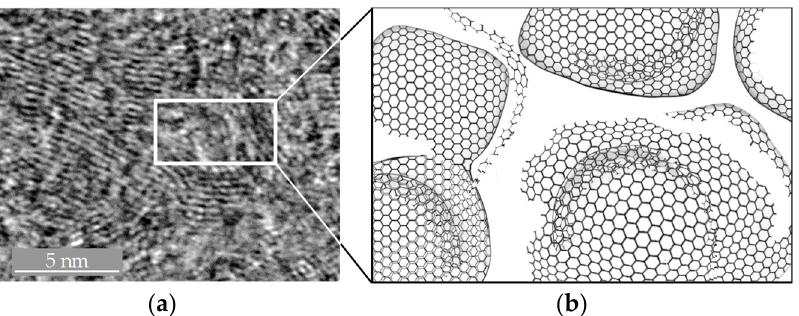
Figure 4. ( a ) Microstructure derived from transmission electron microscope (TEM)-measurement performed at Fraunhofer Institute for Microstructure of Materials and Systems (IMWS) with commercially available Glassy Carbon; ( b ) Model-based visualisation of microstructure according to Harris [18].